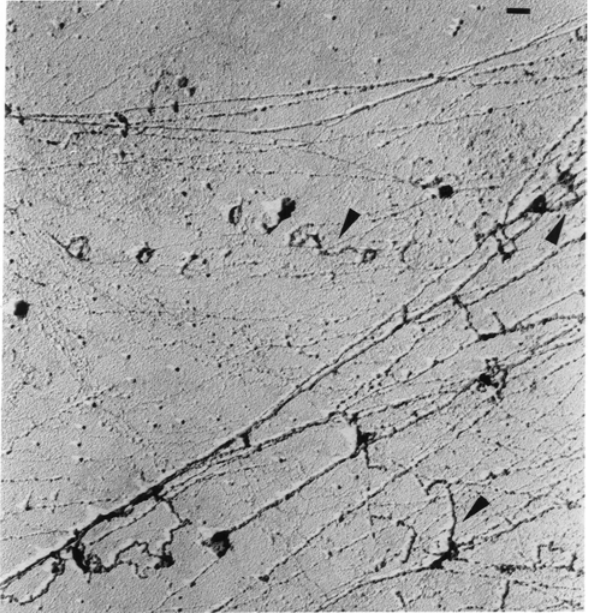
Fig. 1 – Pore-linkedfilaments (arrowheads) are shown in association with chromosome loops (2n; spreading of whole cells; aqueous PTA; Paladium shadowing; bar = 200